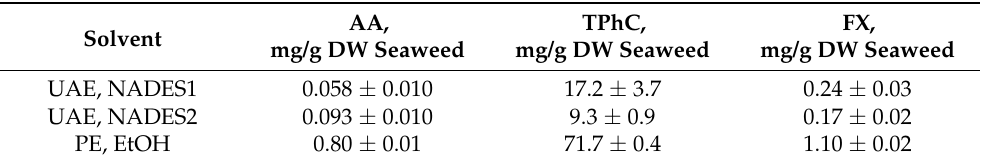
Figure 1. The structures of ascorbic acid, phloroglucinol, fucoxanthin, choline chloride, lactic acid, and glucose. The efficacy of the extraction of hydrophilic and lipophilic compounds from F. vesicu- losus with NADES using UAE was compared with that of ethanol using PE (Table 2). Table 2. The content of hydrophilic-ascorbic acid (AA), total phlorotannins (TPhC), and lipophilic- fucoxanthin (FX) compounds from Fucus vesiculosus after UAE and PE (mean ± standard deviation).